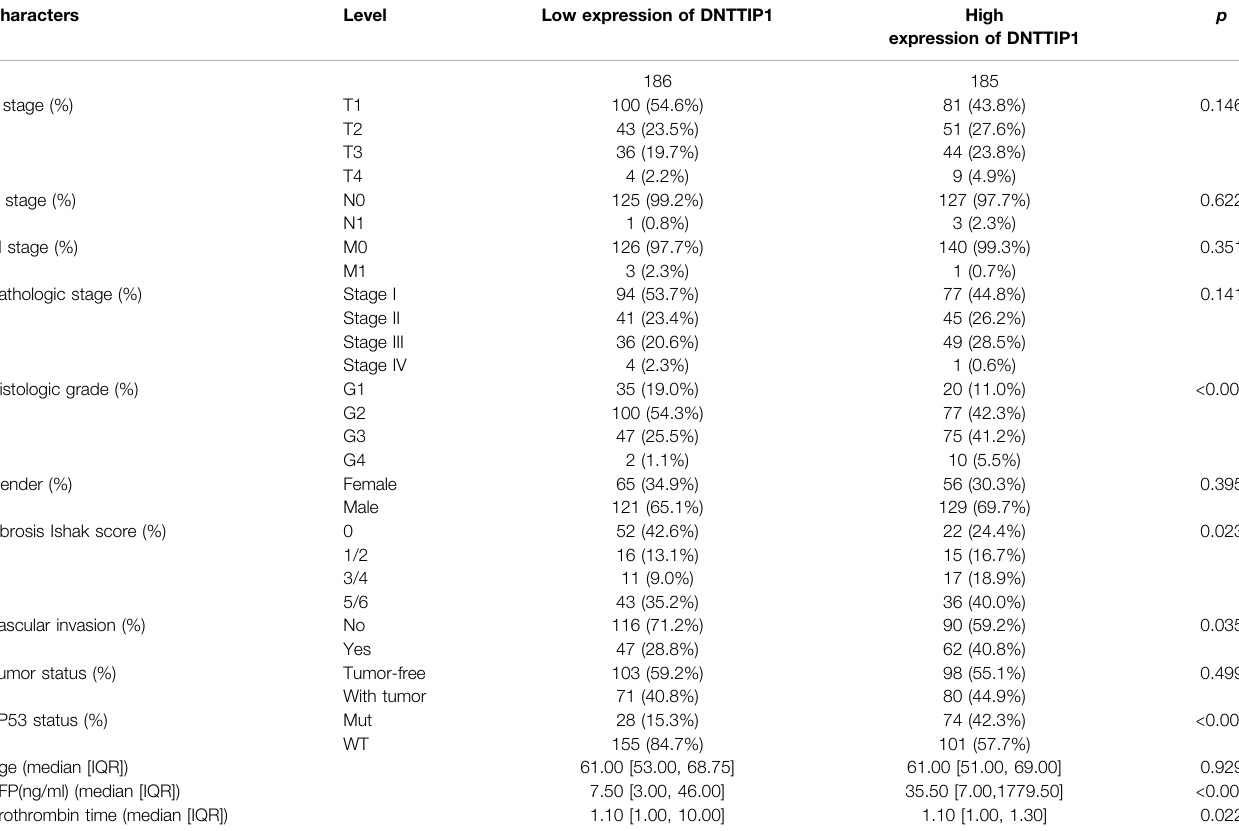
TABLE 1 | Demographic and clinicopathological parameters of patients with hepatocellular carcinoma in TCGA – LIHC.